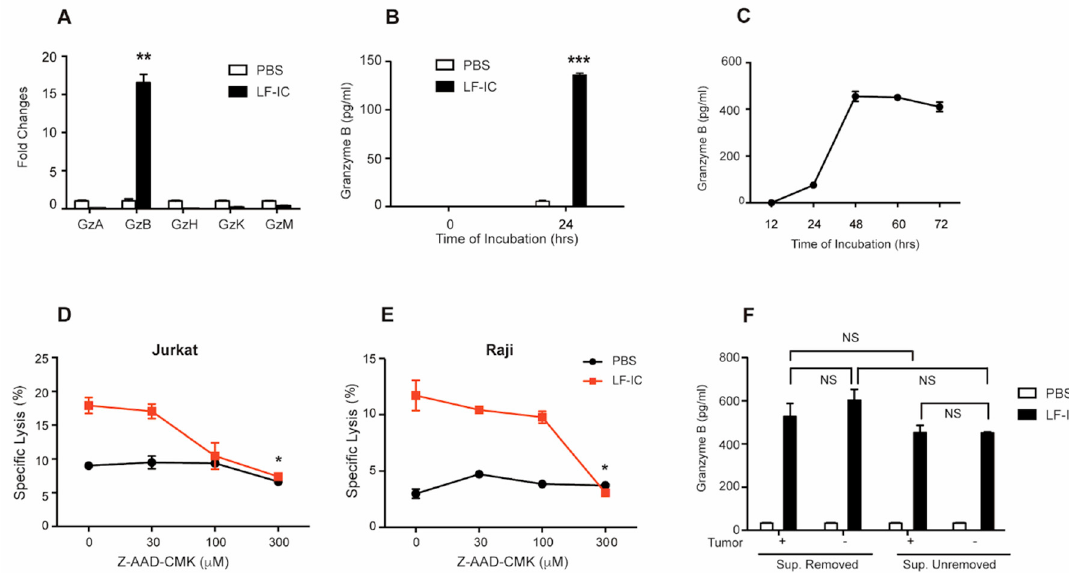
Figure 3. The tumoricidal function of LF-IC-primed human monocytes is dependent on Granzyme B production. Freshly purified human monocytes were primed with 30 µ g / mL M860-IC for 24 h. RNA were extracted and expression of Granzyme family were tested by q-PCR ( A ). GzB in Supernatants was determined by ELISA ( B ). ( C ) Freshly purified human monocytes were primed with 30 µ g / mL LF-IC for 12, 24, 48, 60, 72 h. GzB in Supernatants was determined by ELISA. ( D , E ) Freshly purified human monocytes were primed with 30 µ g / mL LF-IC or PBS for 24 h followed by a further incubation with Jurkat ( D ) or Raji ( E ) in the presence of concentrations of GzB inhibitors (Z-AAD-CMK) for 18 h. Cells were acquired and analyzed by FACS with PI staining. Results were expressed by the percentage of CFSE + PI + cell counts in CFSE + cell counts. ( F ) Freshly purified human monocytes were primed with 30 µ g / mL LF-IC for 24 h. Supernatant were removed and tumor cells were added followed by further incubation for 24 h. In a parallel group, tumor cells were added without supernatant removement. GzB in supernatants was determined by ELISA. * p < 0.05, ** p < 0.01, *** p <